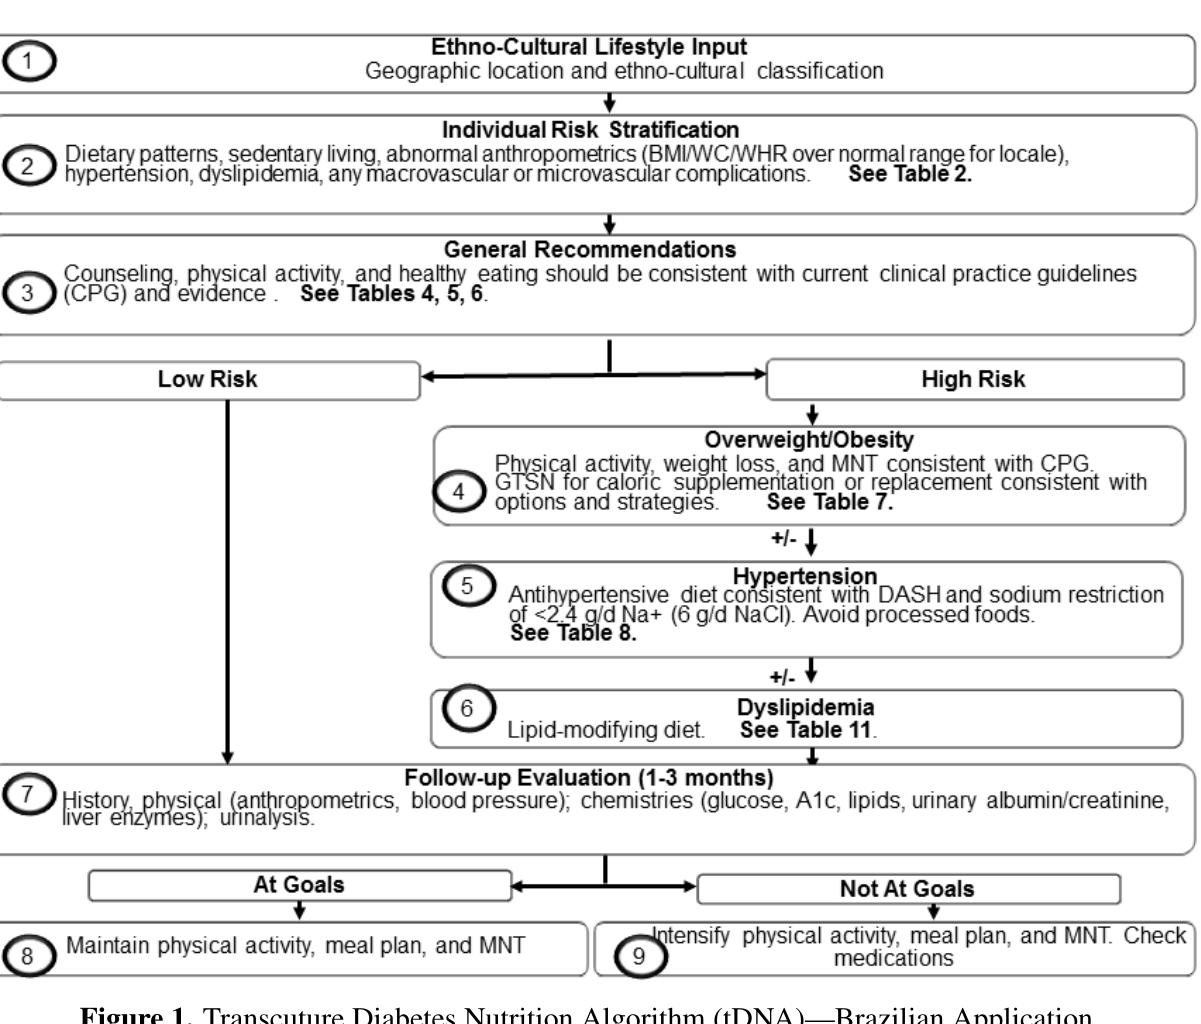
Figure 1. Transcuture Diabetes Nutrition Algorithm (tDNA)—Brazilian Application.